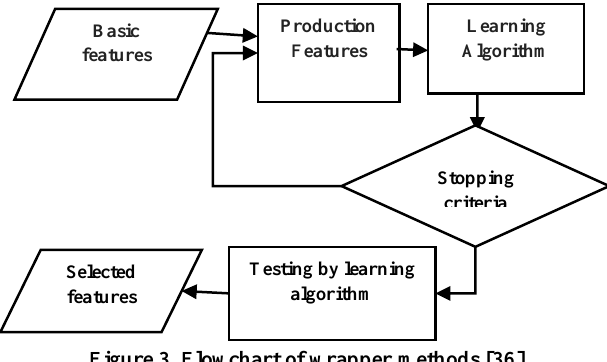
Figure 3. Flowchart of wrapper methods